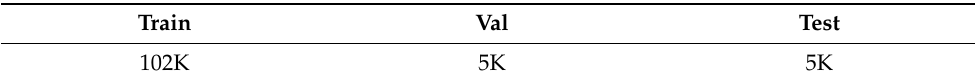
Table 1. Texture dataset partition.